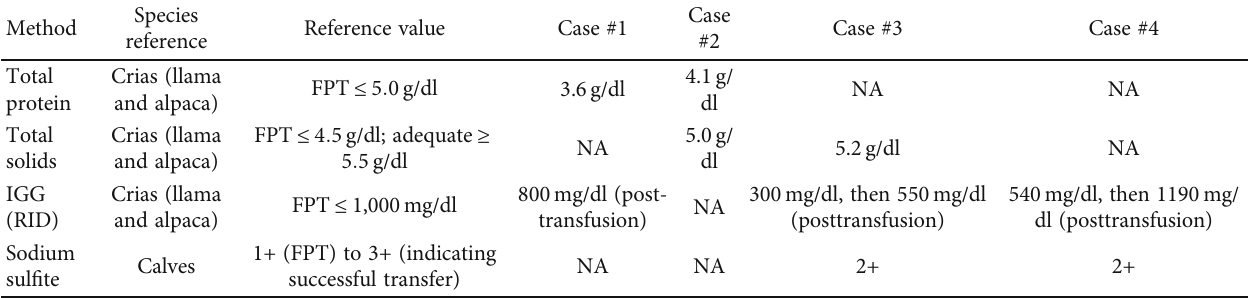
Table 1: Results of various diagnostics for the four camel calves with comparisons to values for crias and calves [9, 13].